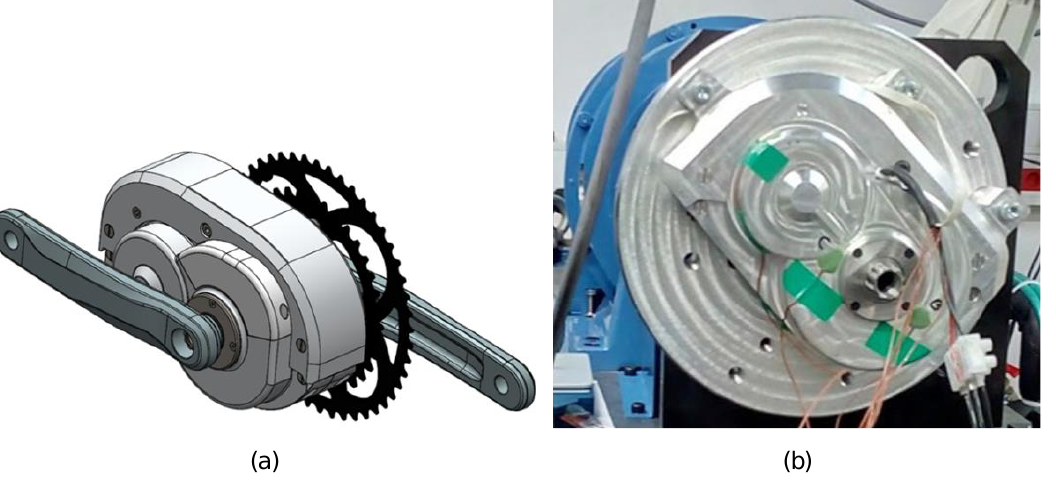
Figure 4. Prototype A2: ( a ) virtual prototype — CAD model; ( b ) testing of a prototype under load at a test site with a brake.